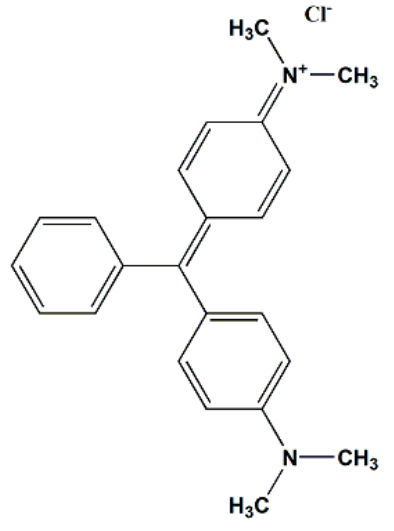
Figure 1. Chemical structure of MG dye.